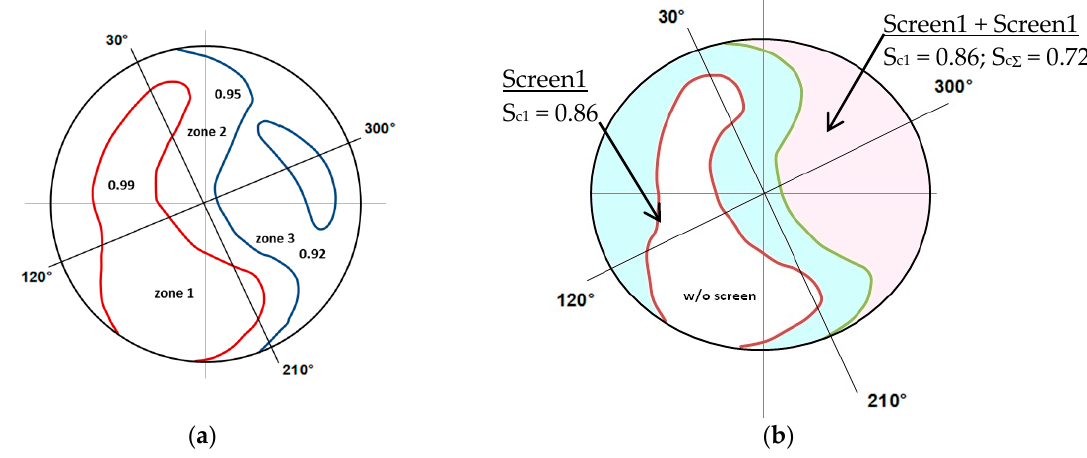
Figure 17. ( a ) Total pressure field at the CRTF2A inlet at R1 speed cor = 94%; ( b ) Schematics of the flow distortion grid.